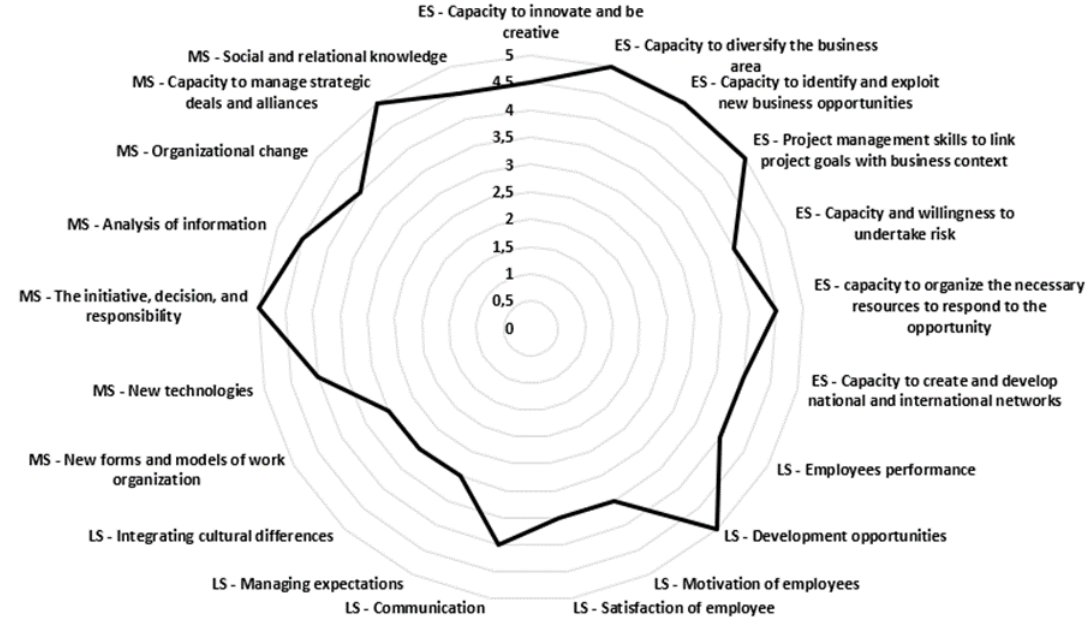
Figure 2. Model Proposal for Entrepreneur Skills Development.